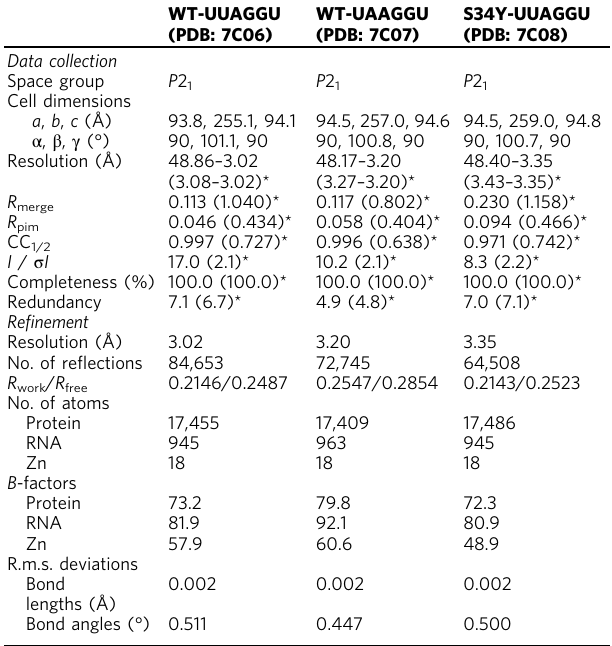
Table 2 Data collection and re fi nement